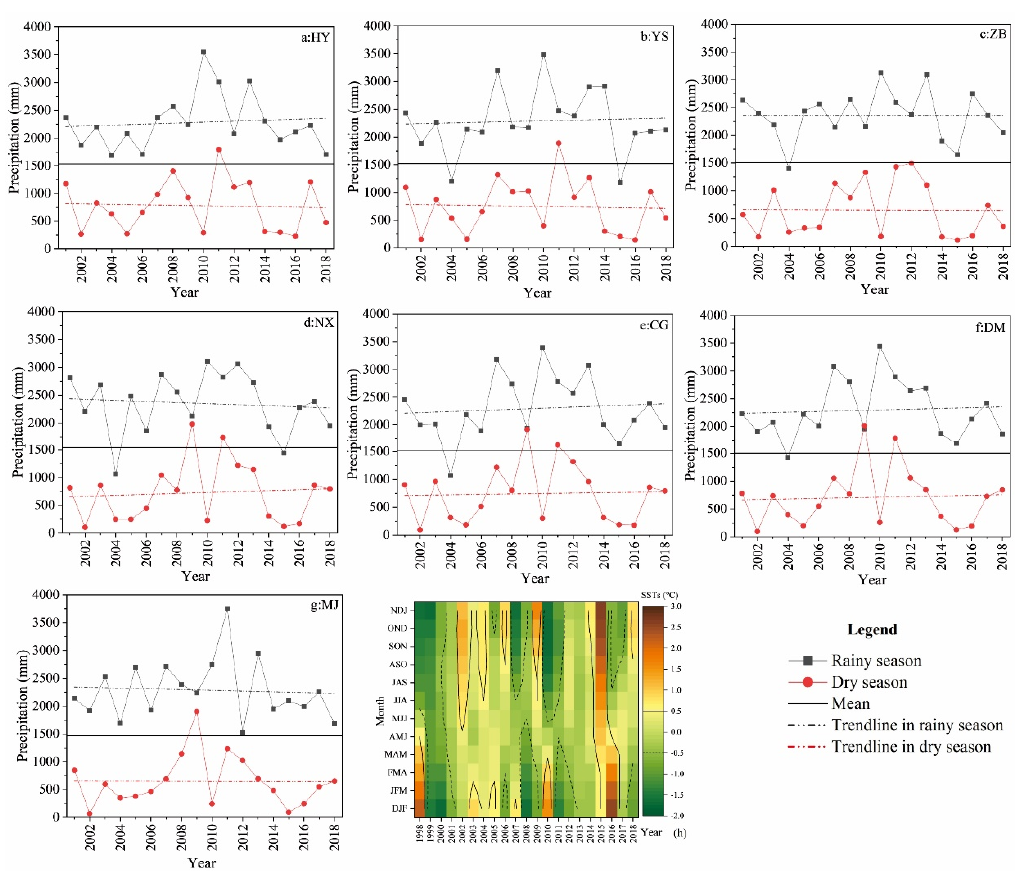
Figure 5. Precipitation in rainy and dry seasons on seven reclaimed islands ( a – g ); the mean was half of the annual mean precipitation. Monthly distribution of ENSO in different years ( h ), black solid line is +5 °C, and black dotted line is − 5 °C.